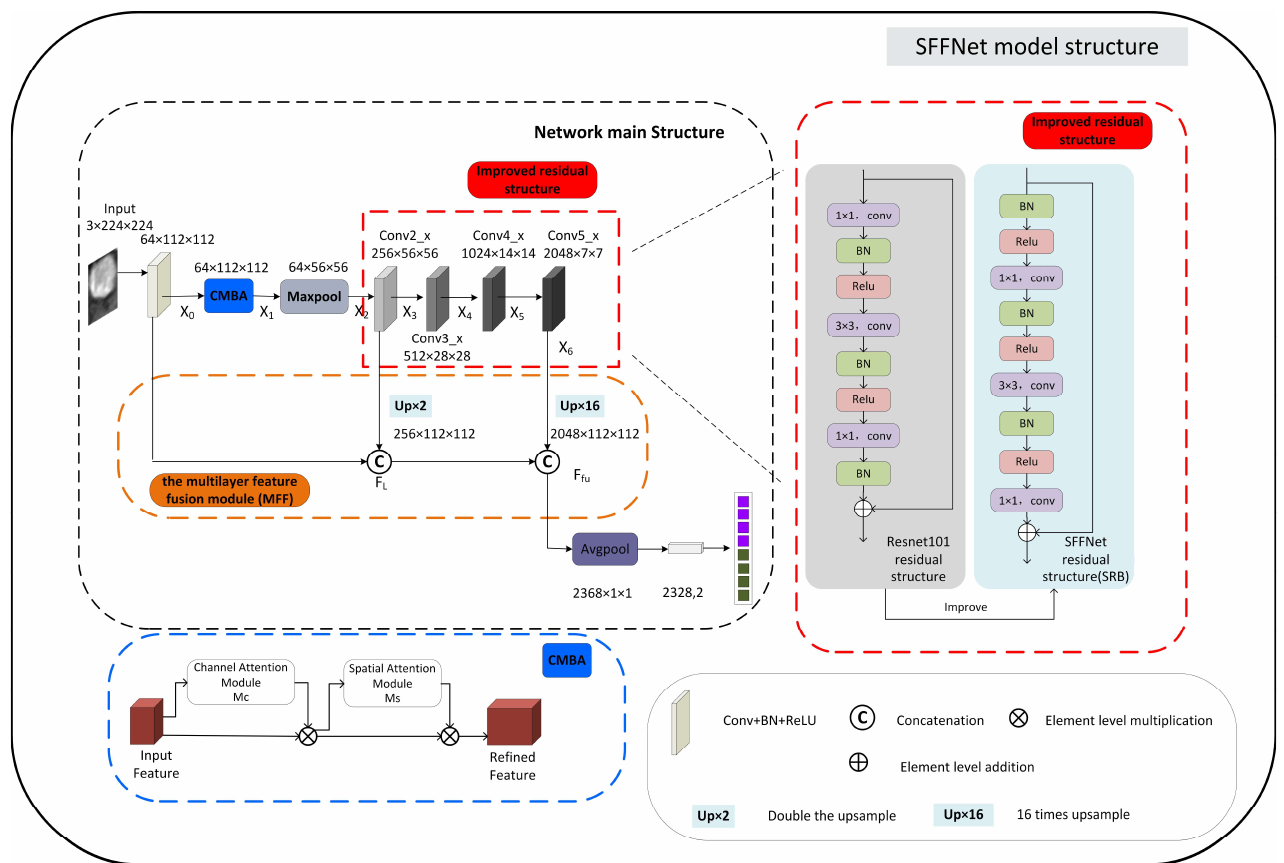
Figure 4. The network structure of strided feature fusion residual network (SFFNet). The multilayer feature fusion module (MFF), stationary residual block(SRB), and convolutional block attention module (CBAM) modules were marked in orange, blue, and red dotted boxes.